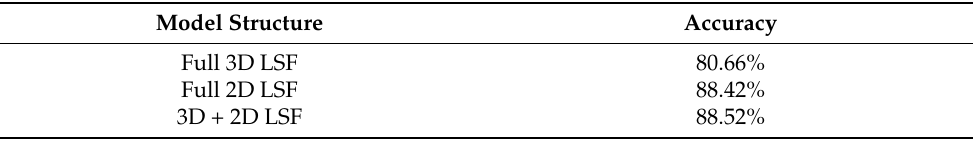
Table 5. Different structure of the front-end. Results are reported in terms of RANK 1 identification accuracy (%) on